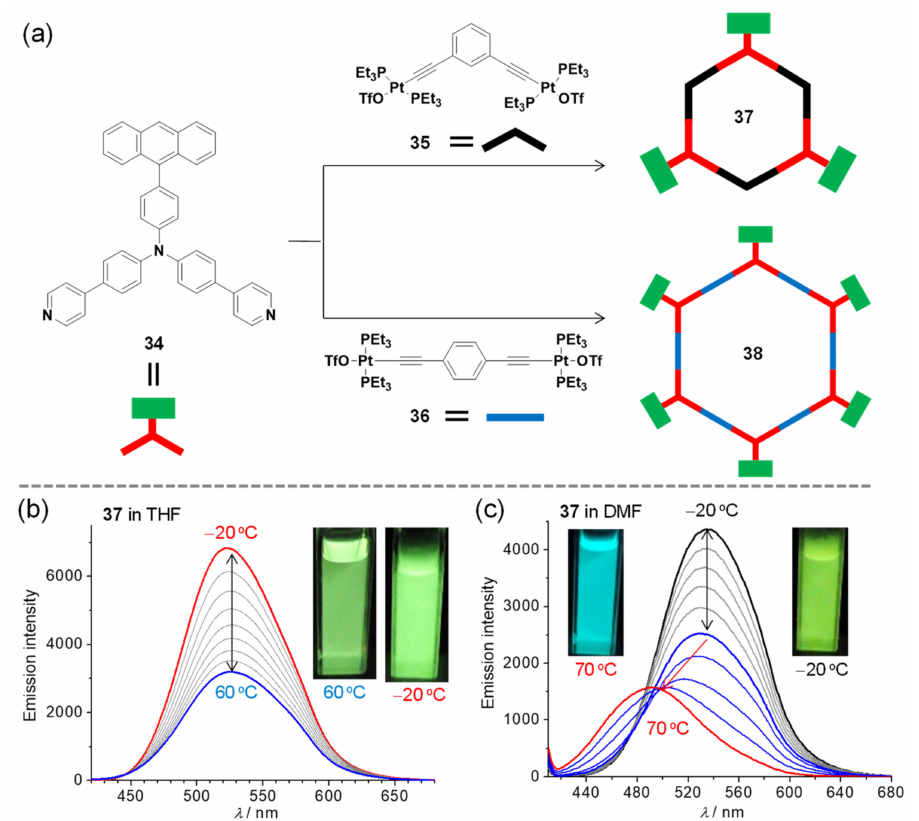
Figure 8. Temperature-responsive fluorescent metallacycles 37 and 38 . ( a ) Scheme of the syntheses of 37 and 38 . ( b , c ) Emission spectral changes of 37 in ( b ) THF and ( c ) DMF, respectively. The inset images show the solution under UV irradiation at specific temperature indicated. Reprinted with permission from Ref. [76]. Copyright 2018 American Chemical